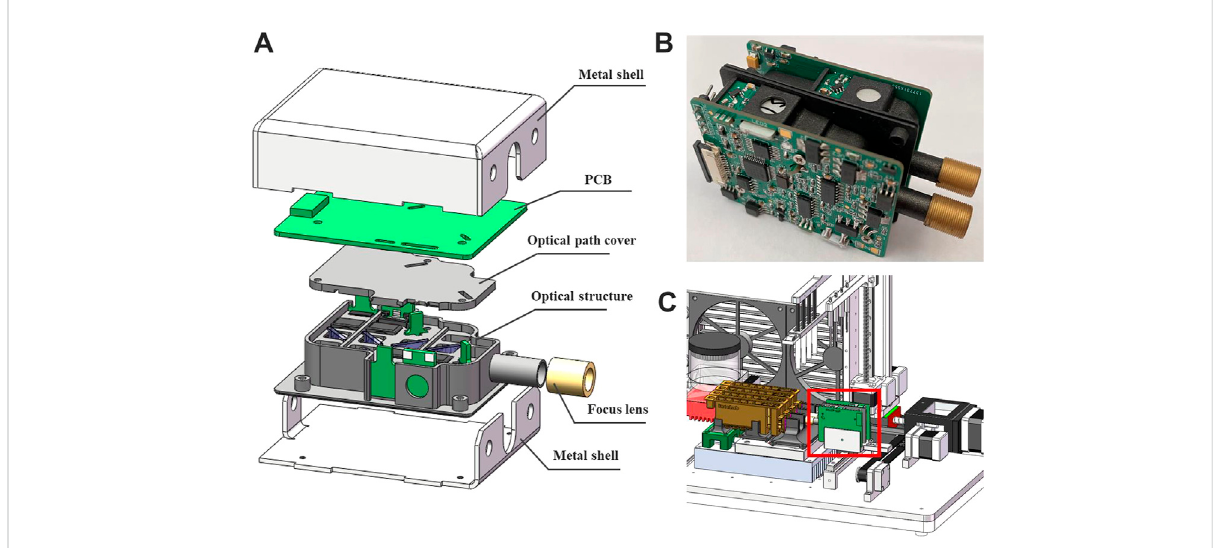
FIGURE 5 (A) Thethree-dimensional(3D)illustrationofthe fl uorescencemoduleinanexplodedview,whichincludesmetalshell,PCB,opticalpathcover, optical structure and focus lens. (B) The photograph of two fl uorescence modules combined together. (C) Integration of the fl uorescence module (in the red box) with a homemade portable nucleic acid detection